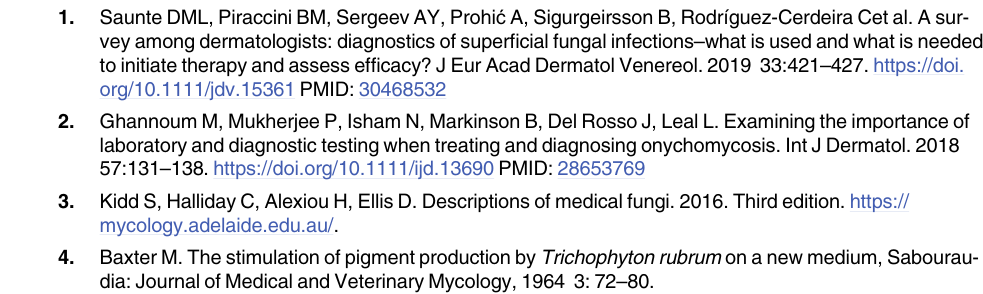
S1 Video. Color change of liquid cultivation medium induced by HCl and NaOH. By add- ing HCl the medium changes to yellow, by adding NaOH it changes to wine-red.